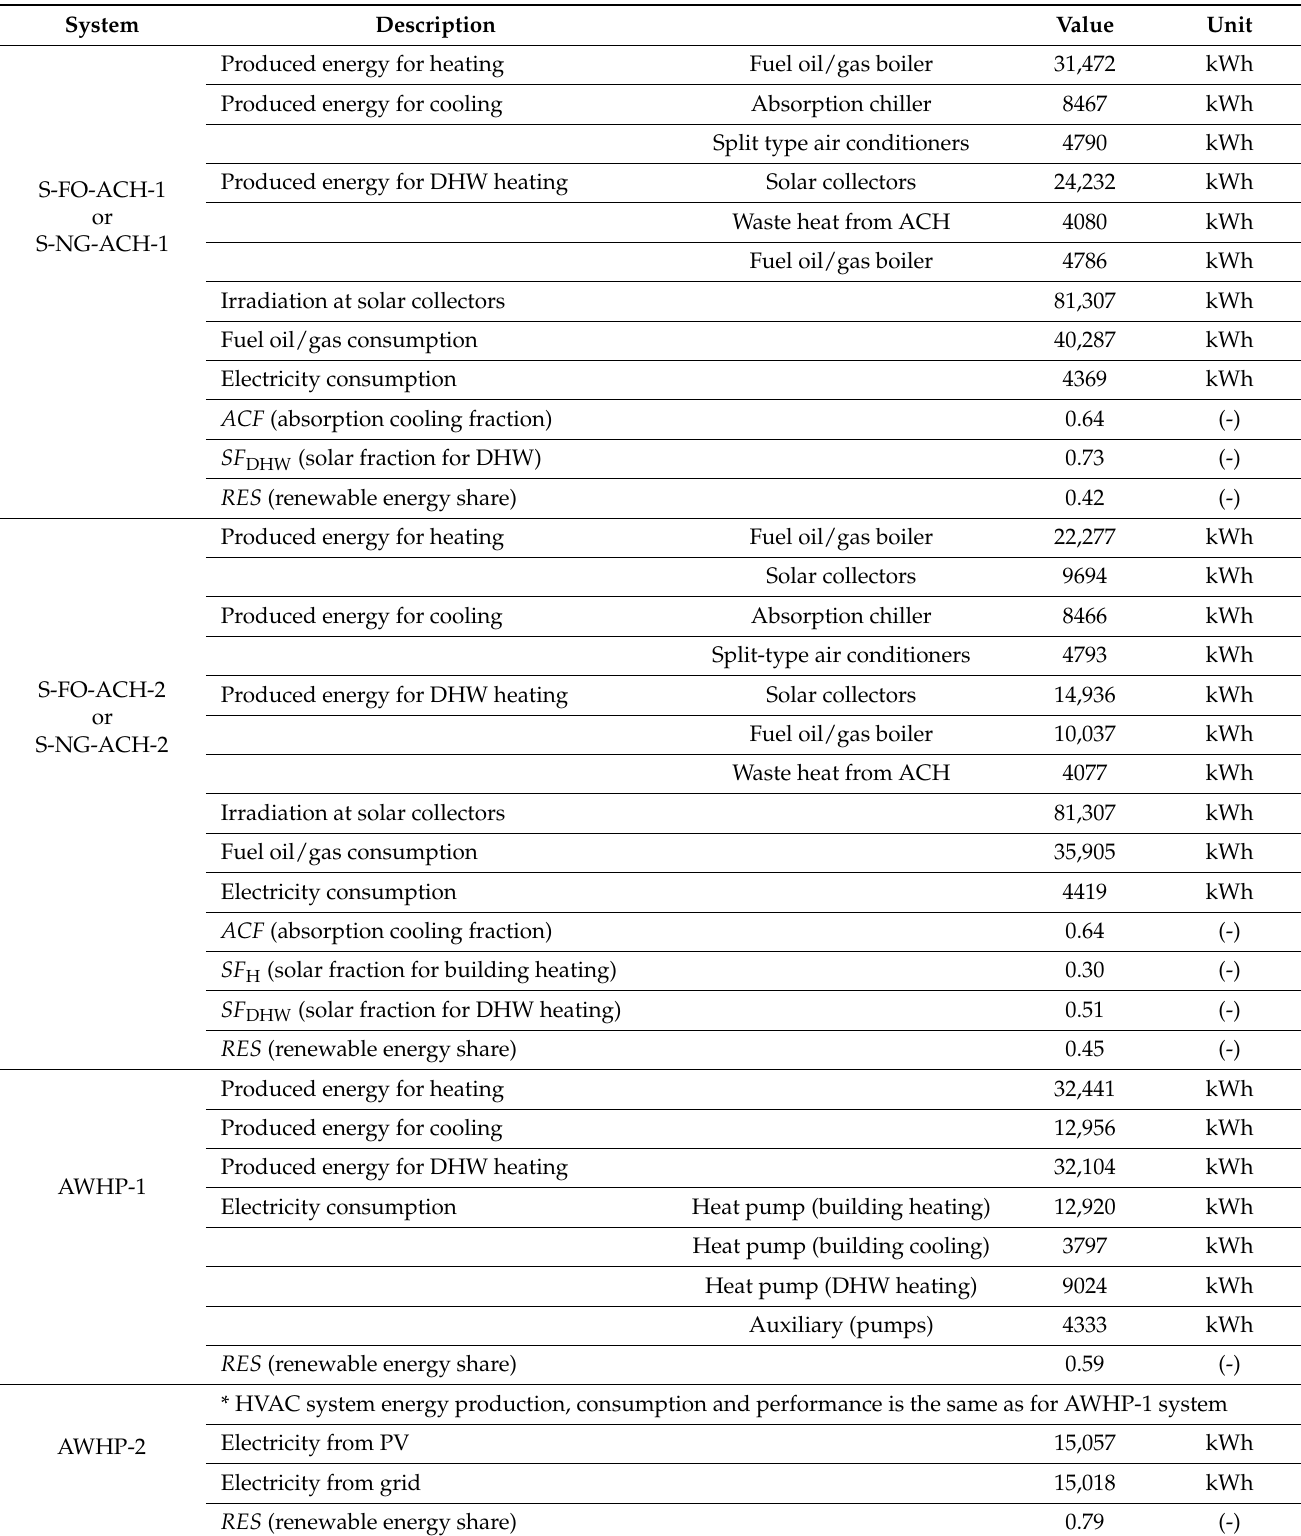
Table 6. Results of HVAC system simulations represented by produced energy, consumed energy and performance